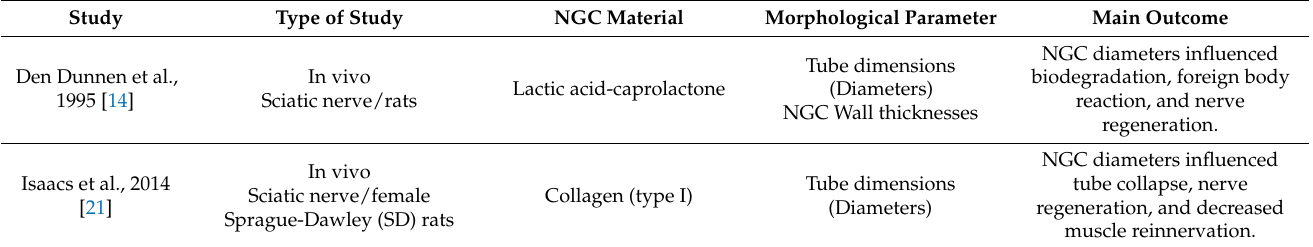
Table 1. Studies evaluating the NGC diameter (adjustment).